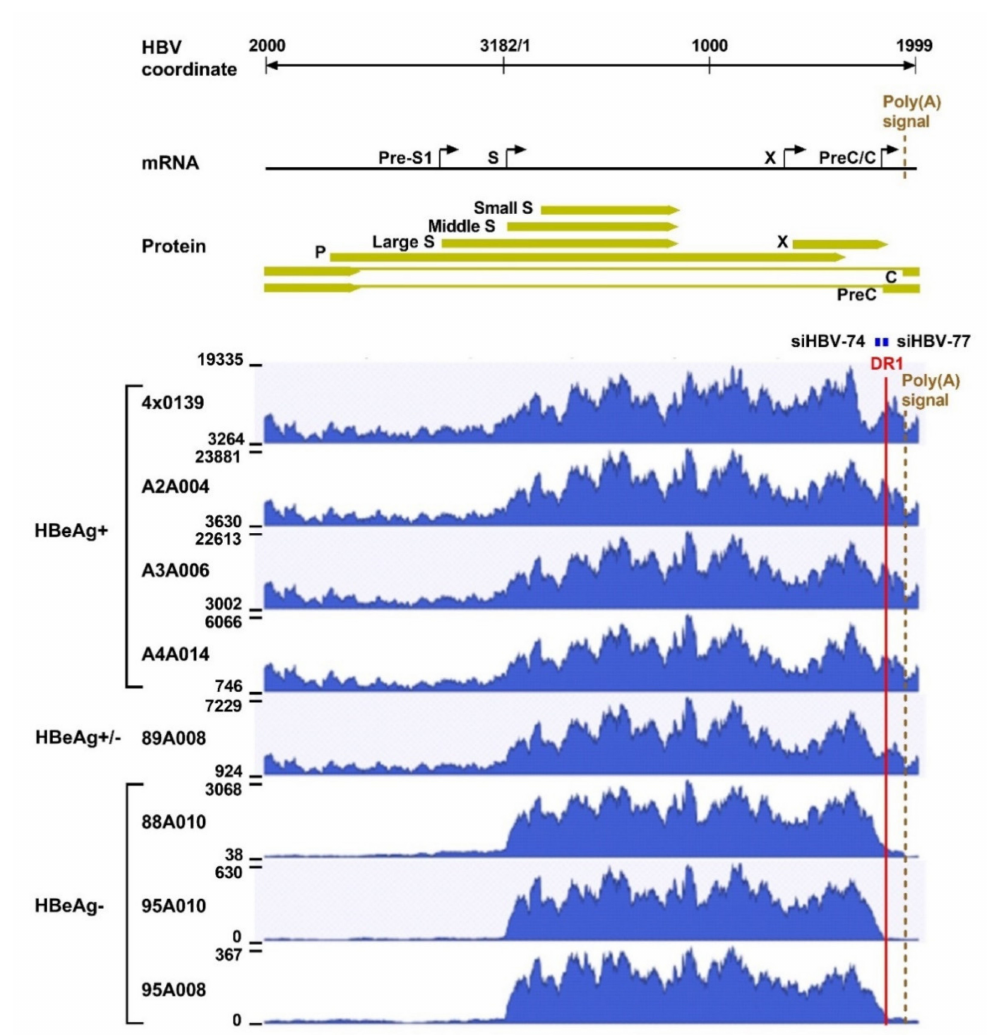
Figure 4. Liver HBV mRNA paired-end sequencing reads in HBeAg-positive and HBeAg-negative chimpanzees treated with ARC-520. The HBV mRNA and HBV protein open reading frames are positioned relative to the coordinates of the HBV genome. The mRNA-seq read histograms are shown for HBeAg-positive chimpanzees 4 × 0139, A2A004, A3A006, and A4A014; for HBeAg transitional chimpanzee 89A008; and for HBeAg-negative chimpanzees 88A010, 95A010, and 95A008. Locations of the DR1 sequence (red line), HBV PAS (brown dashed line), and binding sites for the siRNAs in ARC-520 (siHBV-74 and siHBV-77) are indicated. From [1]. Reprinted with permission from